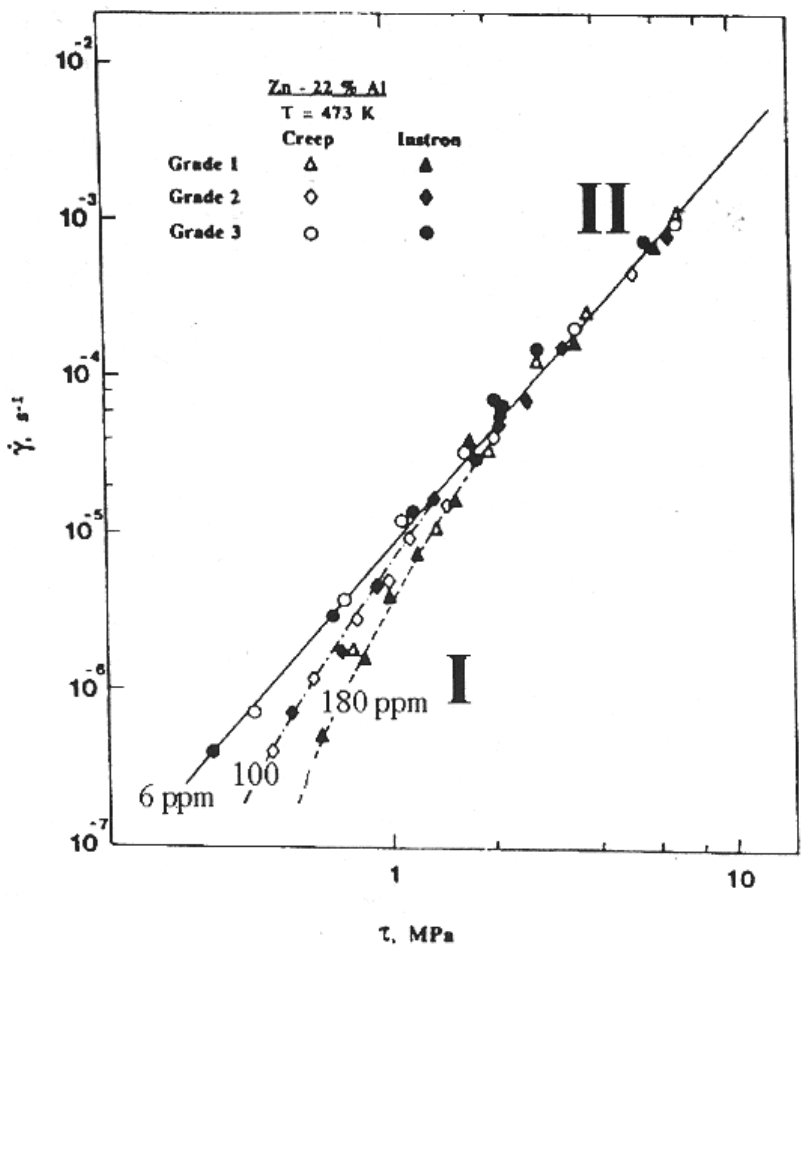
Figure 3. Shear strain rate vs. shear stress (logarithmic scale) for three grades of Zn-22% Al having a grain size of 2.5 µm at 473